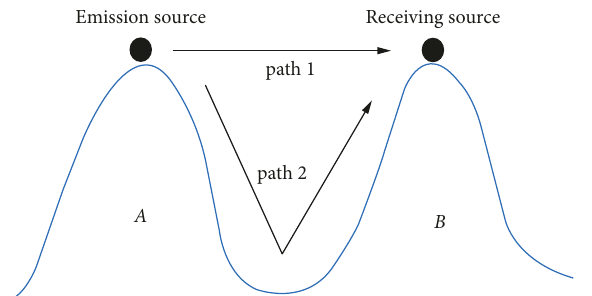
Figure 9: Schematic diagram of the propagation between two